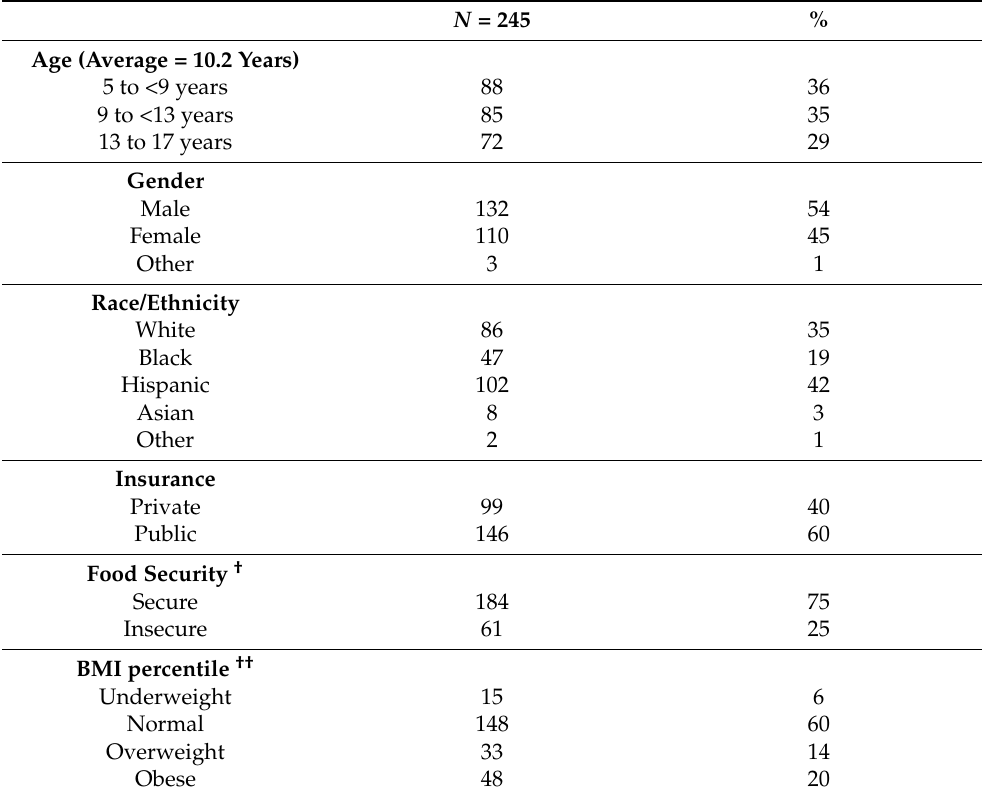
Table 1. Characteristics of children seeking medical care in a pediatric emergency department